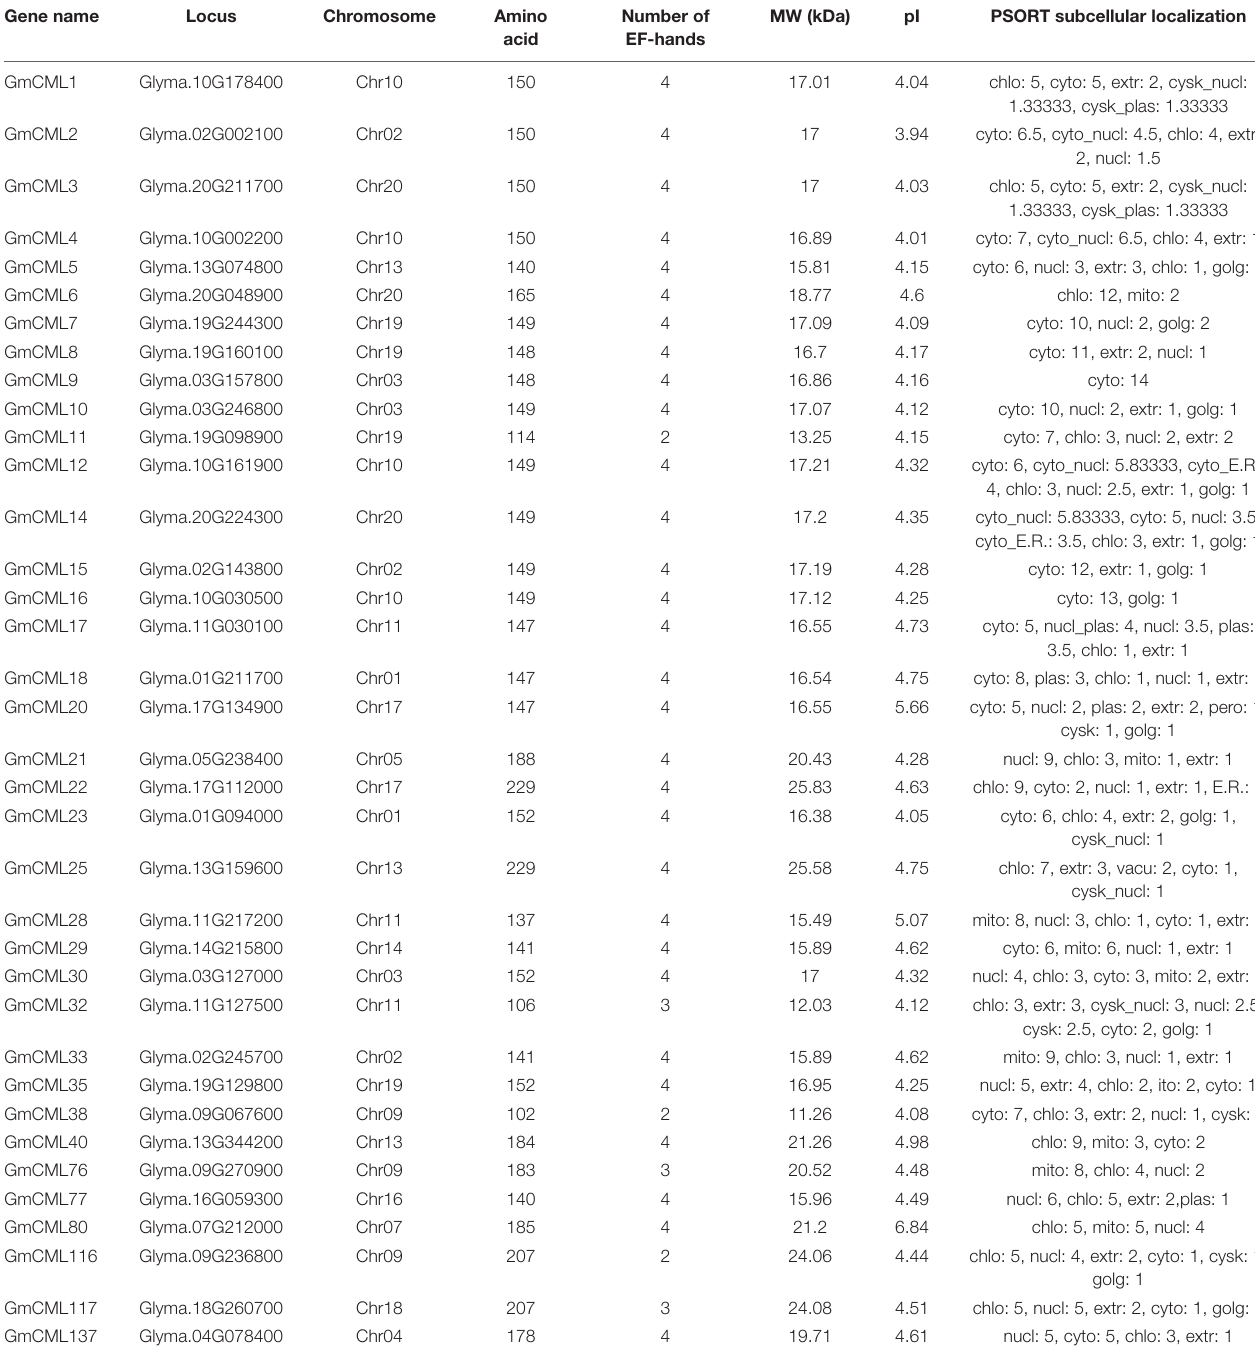
TABLE 1 | Gene locus, chromosome number, number of amino acids, number of EF-hands, molecular weight, pI, and subcellular localization of S. litura -inducible